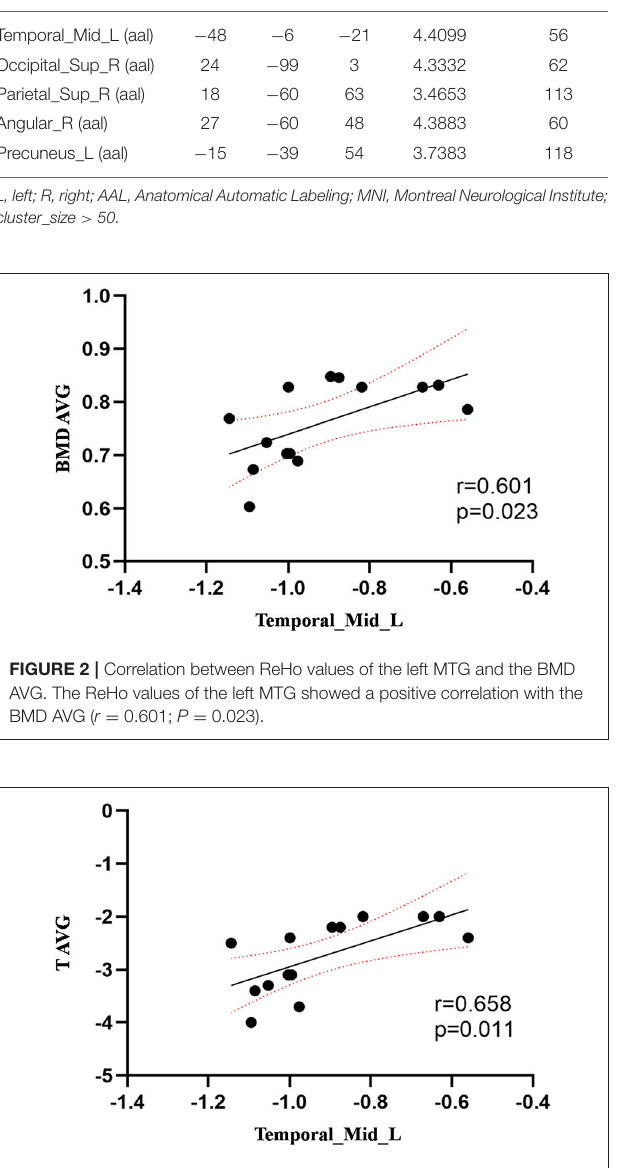
FIGURE 3 | Correlation between ReHo values of the left MTG and the T AVG. The ReHo values of the left MTG showed a positive correlation with the T AVG ( r = 0.658; P =